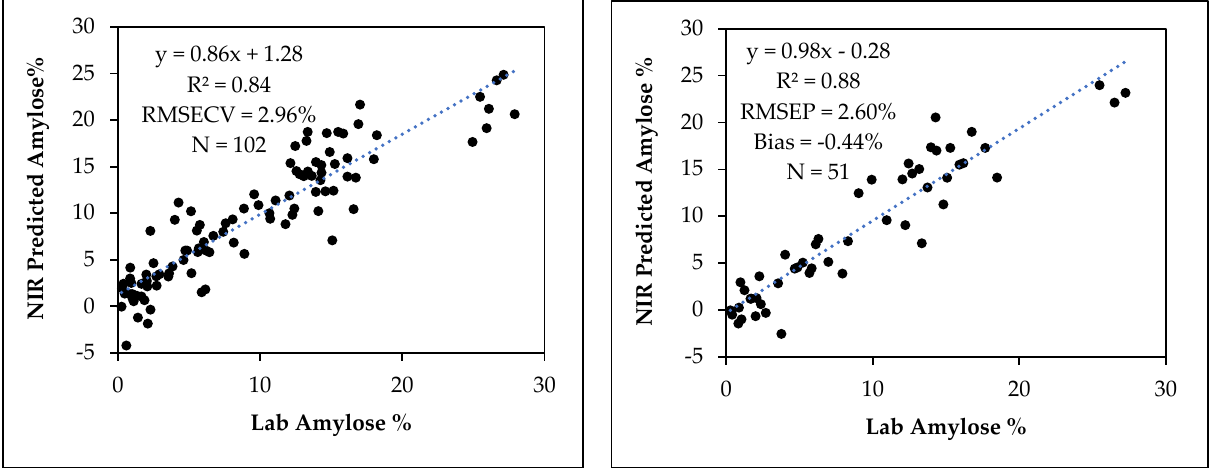
Figure 5. The relationship between laboratory determined and NIR predicted amylose contents for the amylose NIR calibration ( left ) and validation ( right ).